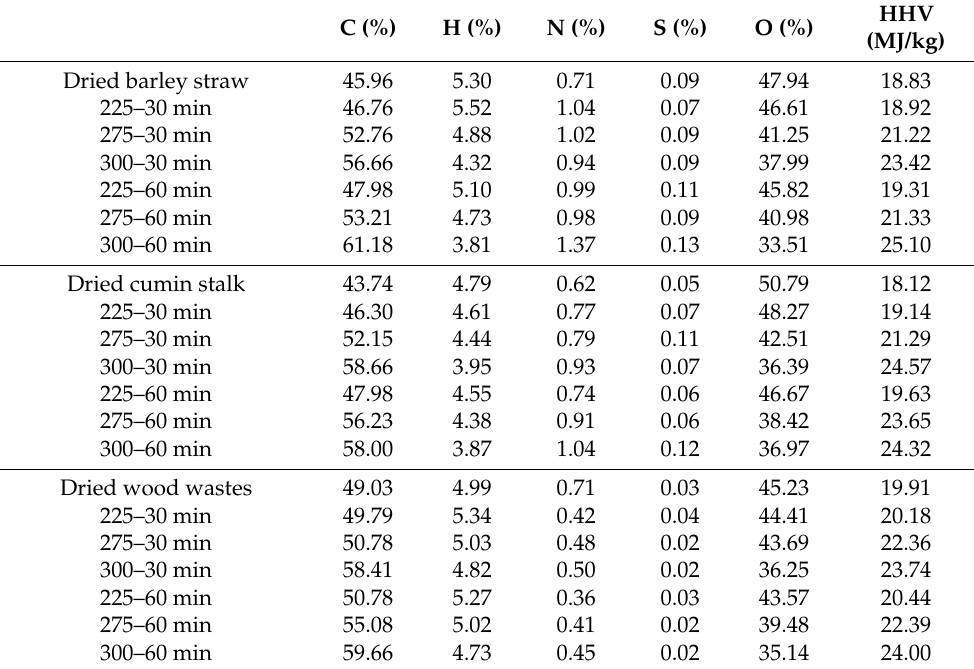
Table 1. Ultimate analysis of biomass before and after torrefaction